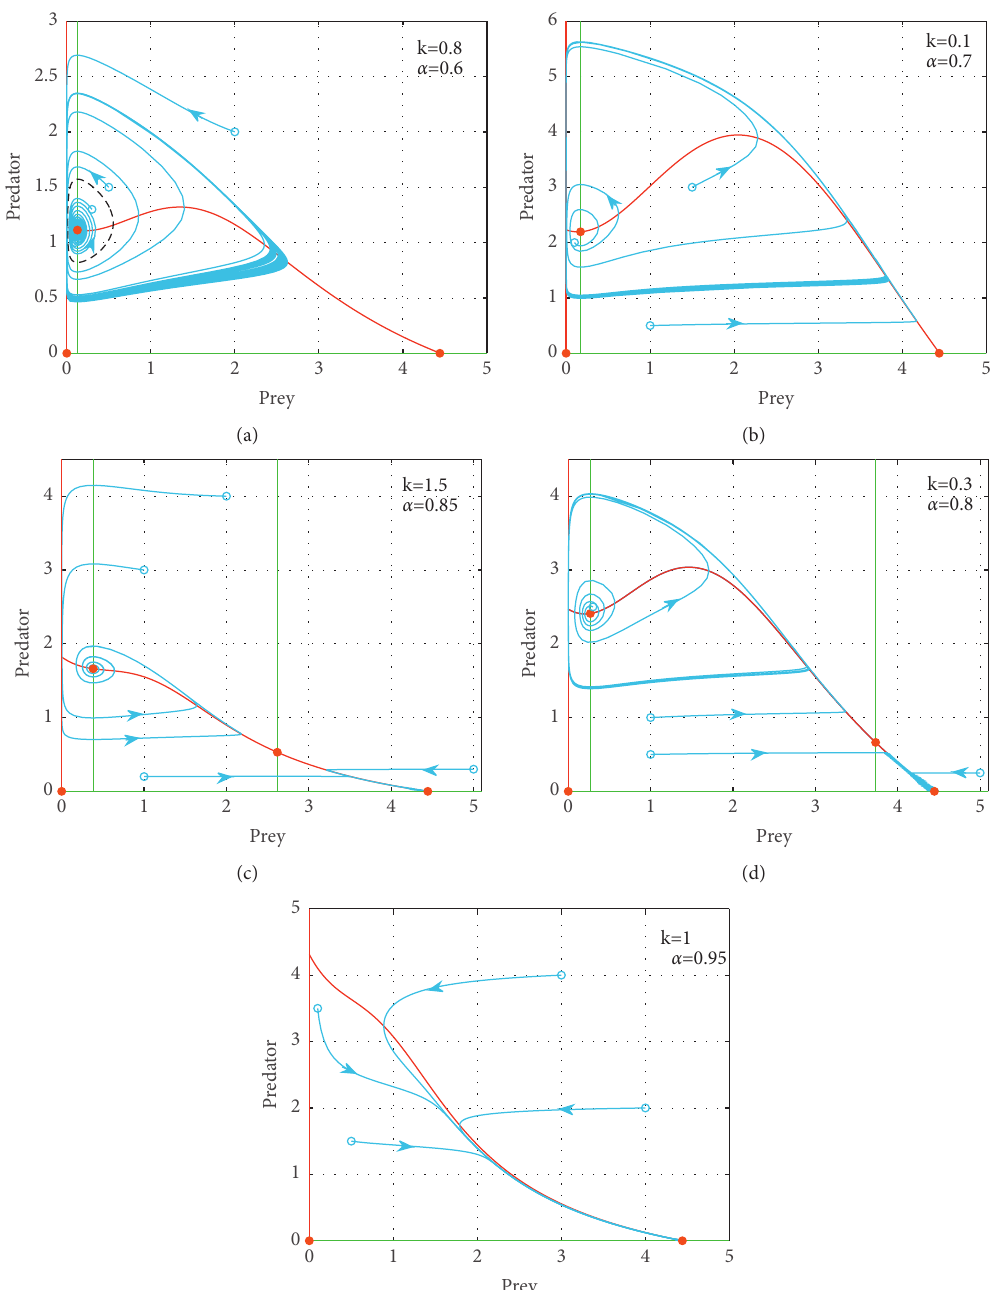
Figure 5: Phase portrait for different representative values of α and k taken from each region of Figure 8. In each figure, all the steady states, specified by small red-coloured filled circles, are the intersection of the prey nullclines (red-coloured curves) and the predator nullclines (green-coloured curves). Trajectories (blue-coloured curves) are drawn for different initial conditions, and all the initial conditions are marked by small blue-coloured circles. The black dotted orbit represents an unstable limit cycle that occurs due to subcritical Hopf bifurcation. Other parameter values are the same as in Figure 6. (a) E 0 (0,0) and E 1 (4.44,0) are unstable; E 2 (0.13,1.11) is locally asymptotically stable. (b) E 0 (0,0) and E 1 (4.44,0) are unstable; limit cycle occurs around E 2 (0.17,2.19). (c) E 0 (0,0) is unstable; E 1 (4.44,0) and E ( 2 . 62 , 0 . 53 ) is unstable. (d) E are locally asymptotically stable; E 0 (0,0) is unstable; E 1 (4.44,0) is locally asymptotically stable; limit cycle 2 2 ( 0 . 27 , 2 . 41 ) ; E ( 3 . 73 , 0 . 66 ) is unstable. (e) E occurs around E 0 (0,0) is unstable; E 1 (4.44,0) is globally asymptotically stable. No coexistence 2 1 2 2 is